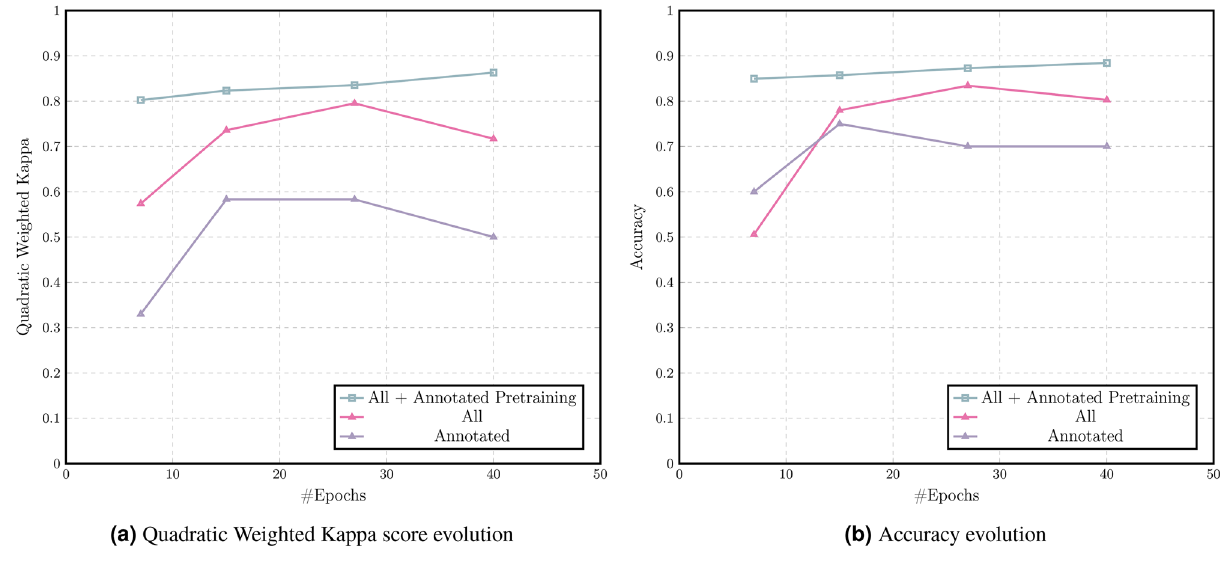
Figure 6. Performance evaluated on CRC